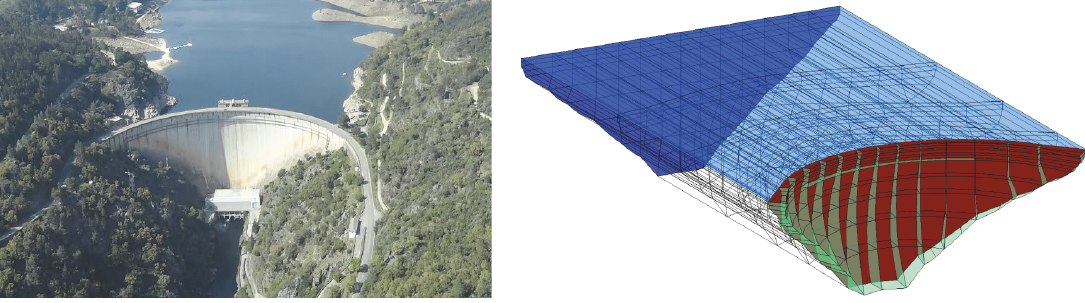
Figure 1: Cabril dam and computational